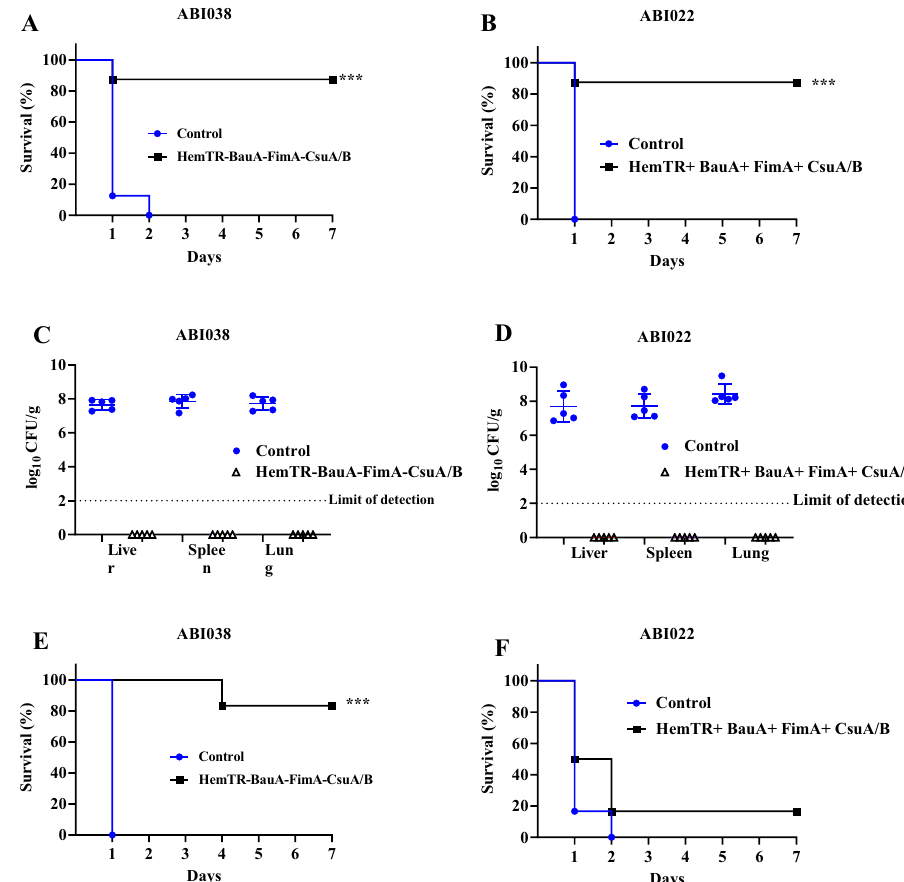
Figure 7. Active and passive immunization against MDR A. baumannii clinical isolates ABI038 and ABI022. ( A , B ) Active immunization with a combination of HemTR-BauA-FimA-CsuA/B recombinant proteins protected mice from minimal lethal dose of clinical isolates. The mice (n = eight mice per group) monitored for 7 days. ( C , D ) Bacterial burden was high in all organs of the adjuvant treated control mice, no colonies were detected after 24 h of infection in test groups challenged with sub-lethal dose of ABI038 and ABI038 (n = five mice per group). ( E , F) Passive immunization with HemTR-BauA-FimA-CsuA/B antibodies protected mice (n = six mice per group) from minimal lethal dose of ABI038, survival rate was 16.66% in mice challenged with ABI022. *** p < 0.001 compared to survival in control